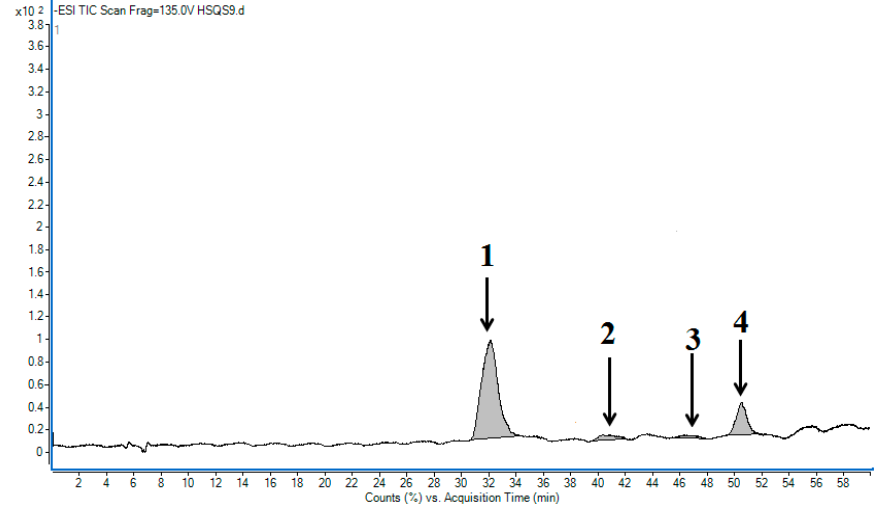
Figure A1. HPLC chromatogram of the PSGslP. The peaks represent (1) luteolin-7-glucoside; (2) acacetin-7-acetyglycoside; (3) acacetin-7-acetyglycoside; and (4) acacetin-7-acetyglycoside.